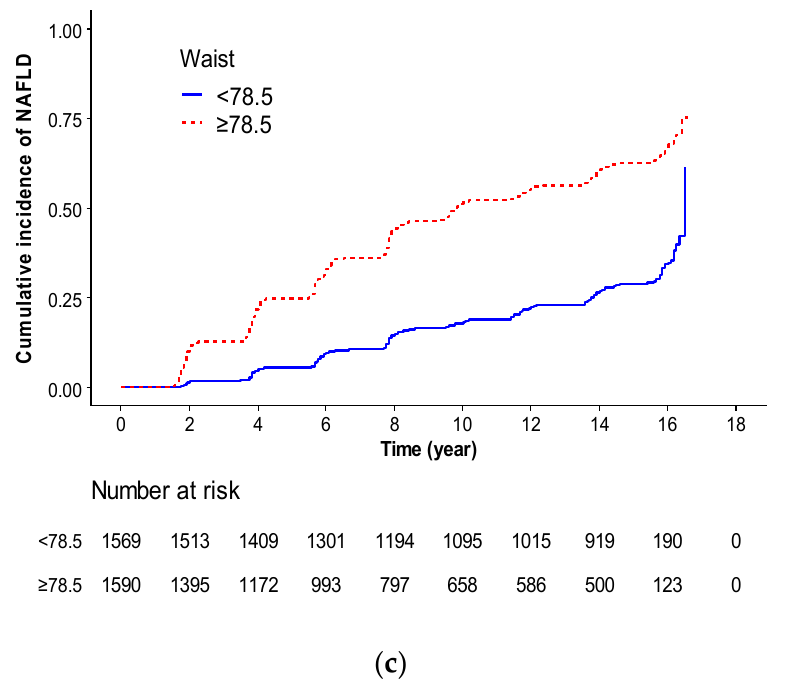
Figure 3. Kaplan–Meier curve for evaluating incident NAFLD identified by waist circumference cutoff points. ( a ) Total participants, < 80.2 cm (blue line) vs. ≥ 80.2 cm (red dot line), ( b ) Men, < 81 cm (blue line) vs. ≥ 81 cm (red dot line), ( c ) Women, < 78.5 cm (blue line) vs. ≥ 78.5 cm (red dot line). Table 3. Cox regression analysis for incidence of non–alcoholic fatty liver diseases according to the optimal waist circumference values by